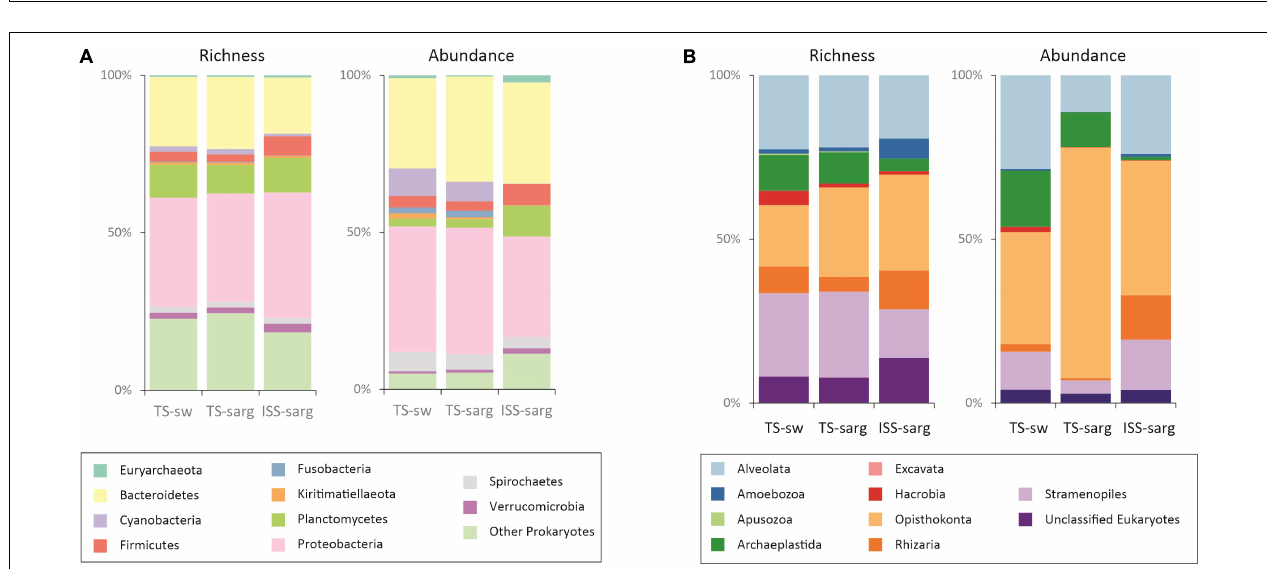
FIGURE 3 | Molecular inventory of the biodiversity associated with Sargassum tides from 100 sampled sites. Differences in the observed OTU richness and relative abundance of seawater at tide sites (TS-sw), Sargassum at tide sites (TS-sarg) and inland Sargassum from storage sites (ISS-sarg). (A) Prokaryotic diversity corresponds to 22,214 OTUs obtained from 2,849,100 reads. (B) Eukaryotic diversity corresponds to 17,679 OTUs obtained from 5,326,300 reads.